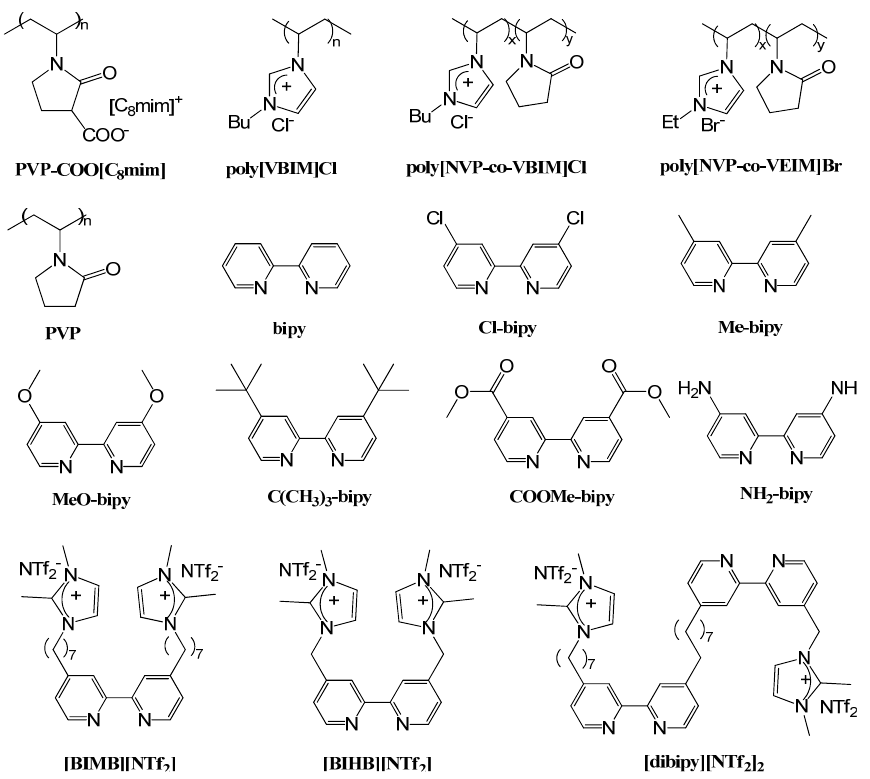
Figure 4. The structures and abbreviations of additional stabilizers described in this